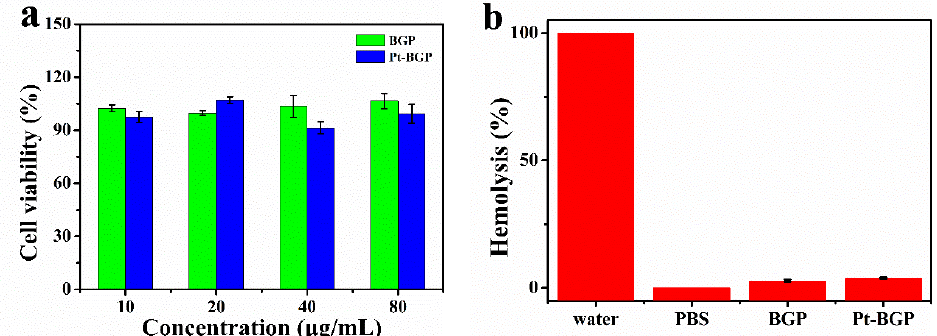
Figure 8. ( a ) Cell viability of HeLa cell after treatment with BGP and Pt-BGP NCs; ( b ) hemolysis rate and corresponding photos of red blood cells incubated with BGP and Pt-BGP NCs (100 μg/mL) at 37 °C for 4 h, respectively.